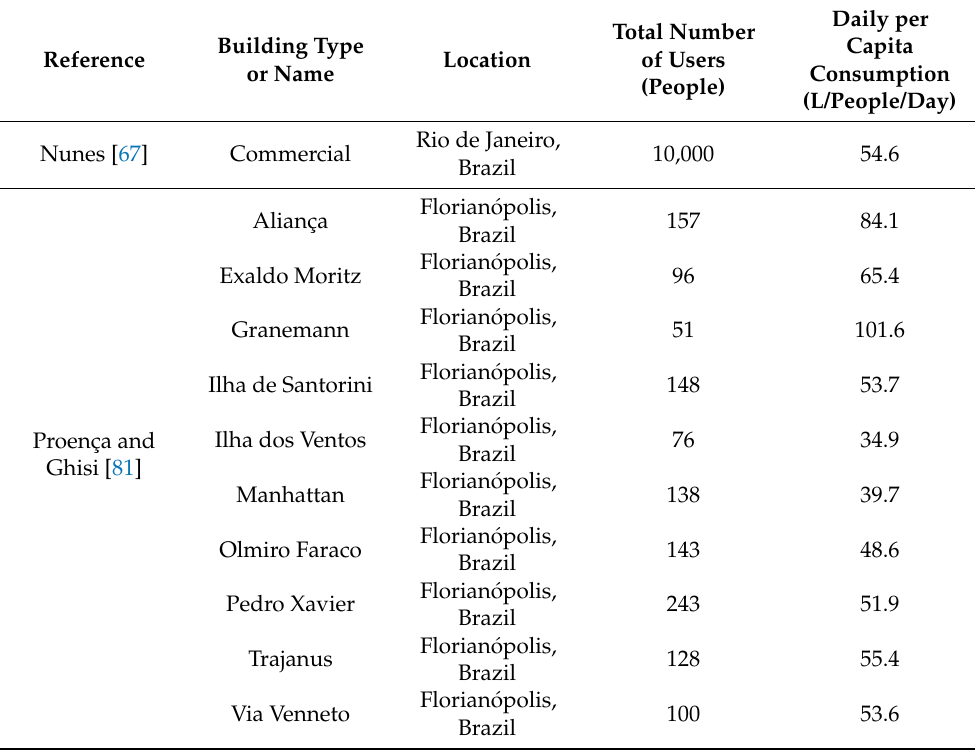
Table 3. Water consumption profiles in office buildings.